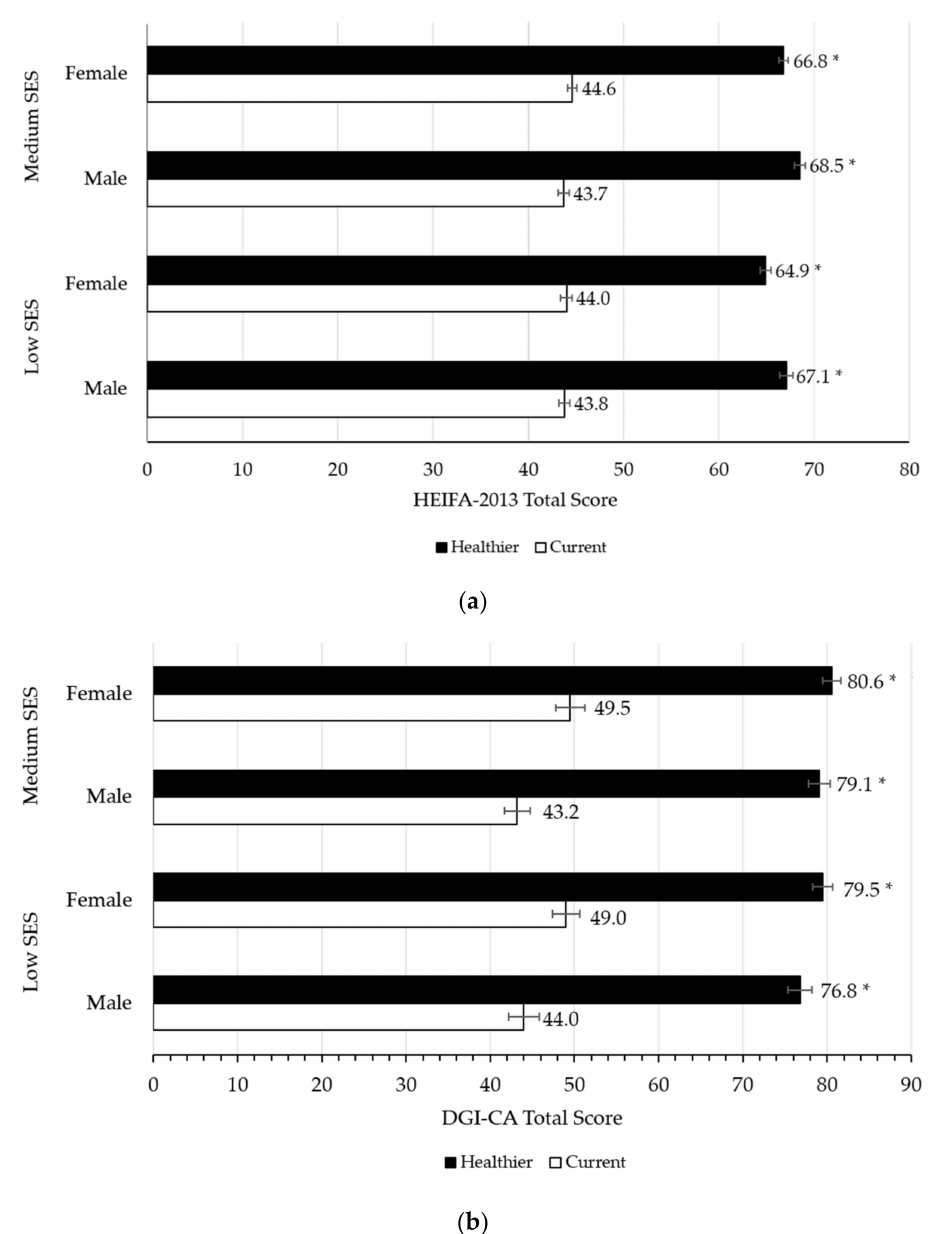
Figure 2. Diet quality of the current and healthier, low-cost diets, using validated diet quality indices. ( a ) HEIFA-2013 (Healthy Eating Index for Australian Adults) [40] assessment of the adult male and adult female current and healthier, low-cost diets, from each of the low and medium SES households; ( b ) DGI-CA (Dietary Guidelines Index for Children and Adolescents) [41–43] assessment of the male and female children’s current and healthier, low-cost diets, from each of the low and medium SES households. Statistical significance is denoted by * p < 0.005. Comparisons are between current and healthy diets within each group. SES, socioeconomic